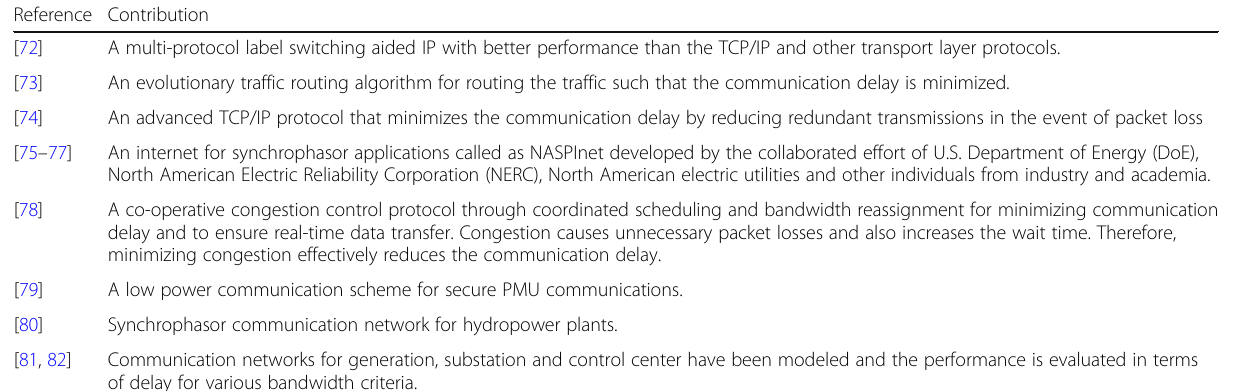
Table 5 Synchrophasor Communication Schemes Reference Contribution